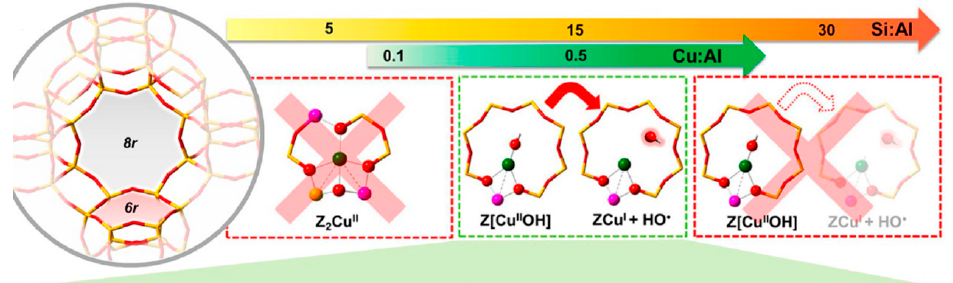
Figure 16. Rationalization of the effect of composition (Cu:Al and Si:Al ratios) on the productivity for DOMTM over Cu/SSZ ‐ 13, reported as a full dark red line. Reprinted with permission from [34]. Copyright 2017 American Chemical Society.